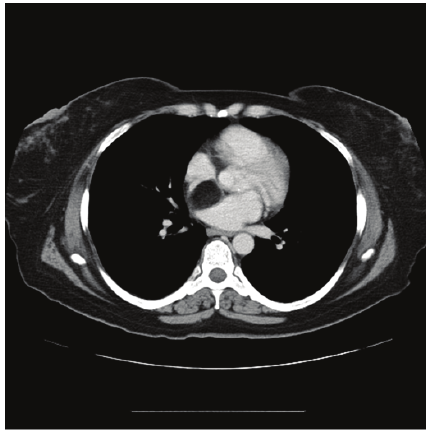
Figure 4: Coronal CT reconstruction shows how the superior vena cava tapers distally, as it is compressed by the lipoma.